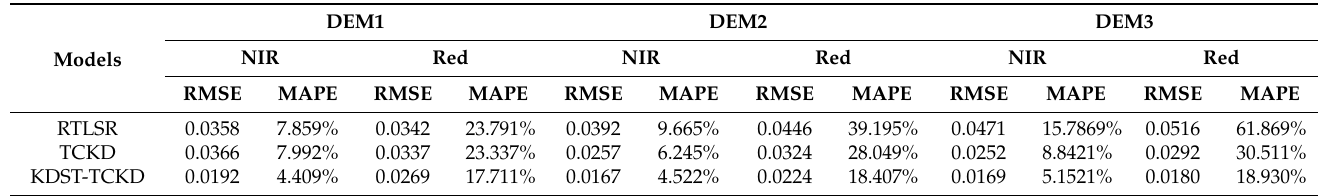
Figure 8. Comparison of performance of the RTLSR model, TCKD model and KDST-TCKD model in red and NIR bands. The abscissa was divided into three groups, representing the three terrains of Figure 1 with mean slopes of 9.13°, 22.83°, and 33.40°, respectively. The width of the violin plot represents the frequency of the RMSE distribution. Table 1. Accuracy statistics of RTLSR model, TCKD model and KDST model in the red and NIR bands over three different